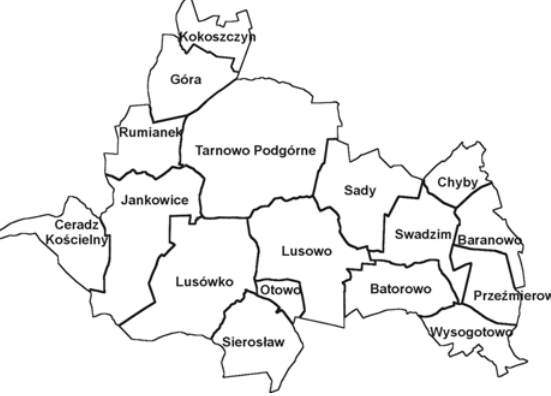
Fig. 3. Tarnowo Podgórne commune as the research area – division into sołectwa (village units). Source: own compilation.